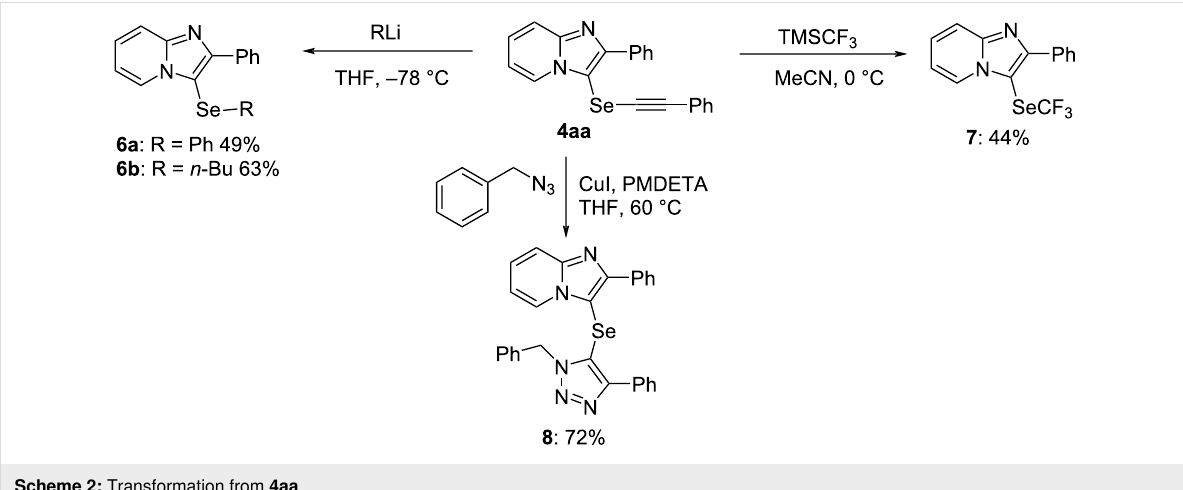
Treatment of 4aa with two equivalents of phenyllithium in THF elimination of the ethynyl group to form the desired phenylimi- dazopyridinyl selenide 6a in 49% yield. In the reaction